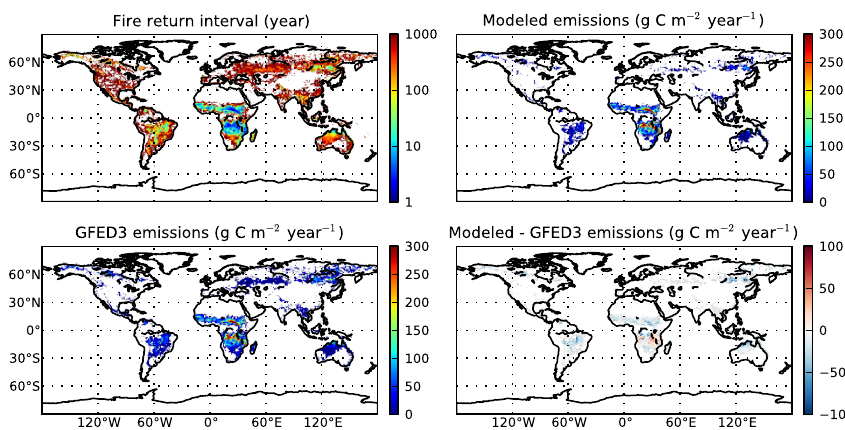
Fig. 8. Fire return intervals based on inverting the mean fraction of each grid cell that burned over 1997–2010 (top left), modelled emissions based on the fire return intervals and the Olson equation (top right), GFED3 emissions (bottom left), and the difference between modelled and GFED3 emissions (bottom right).